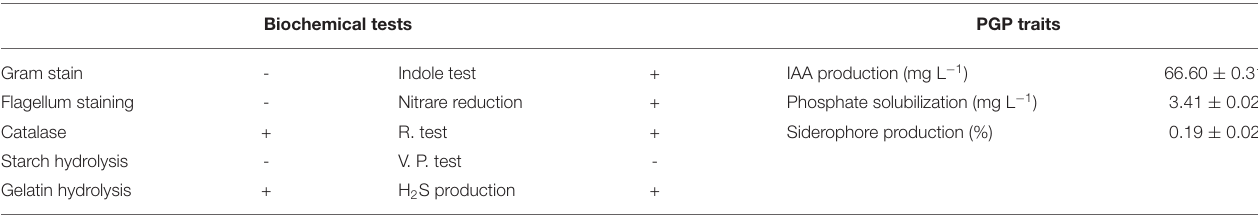
TABLE 1 | Physiochemical characteristics and plant growth-promoting (PGP) properties of